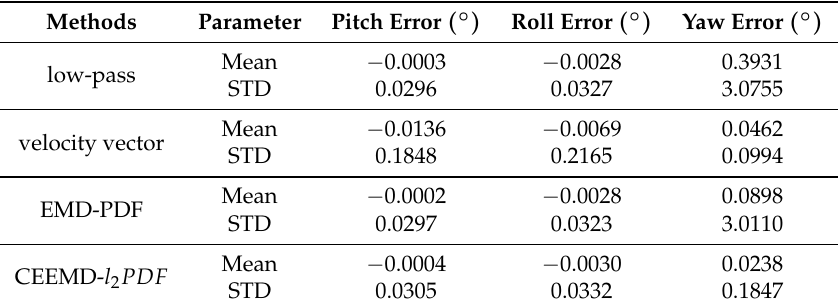
Figure 11. The alignment errors of low-pass, velocity vector, EMD-PDF, and CEEMD- l 2 PDF in the simulation. Table 5. Means and STDs of the alignment errors in the turntable